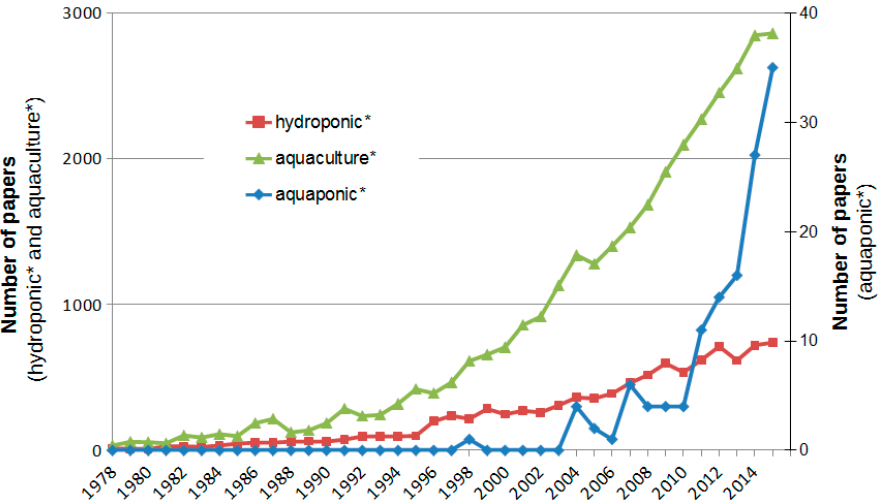
Figure 1. The number of papers published on hydroponic*, aquaculture*, and aquaponic* ‡ from 1978 to 2015 (data were collected from the Scopus database on 17 September 2016). ‡ Please note that the scale for aquaponic* is two orders of magnitude lower than hydroponic* or aquaculture*. Table 1. Number of scientific publications according to Google Scholar for some environmental- and ecotechnologies (patents and citations excluded), compared to the number as indicated by search results in Google. The keywords were evaluated on 3 August 2016.